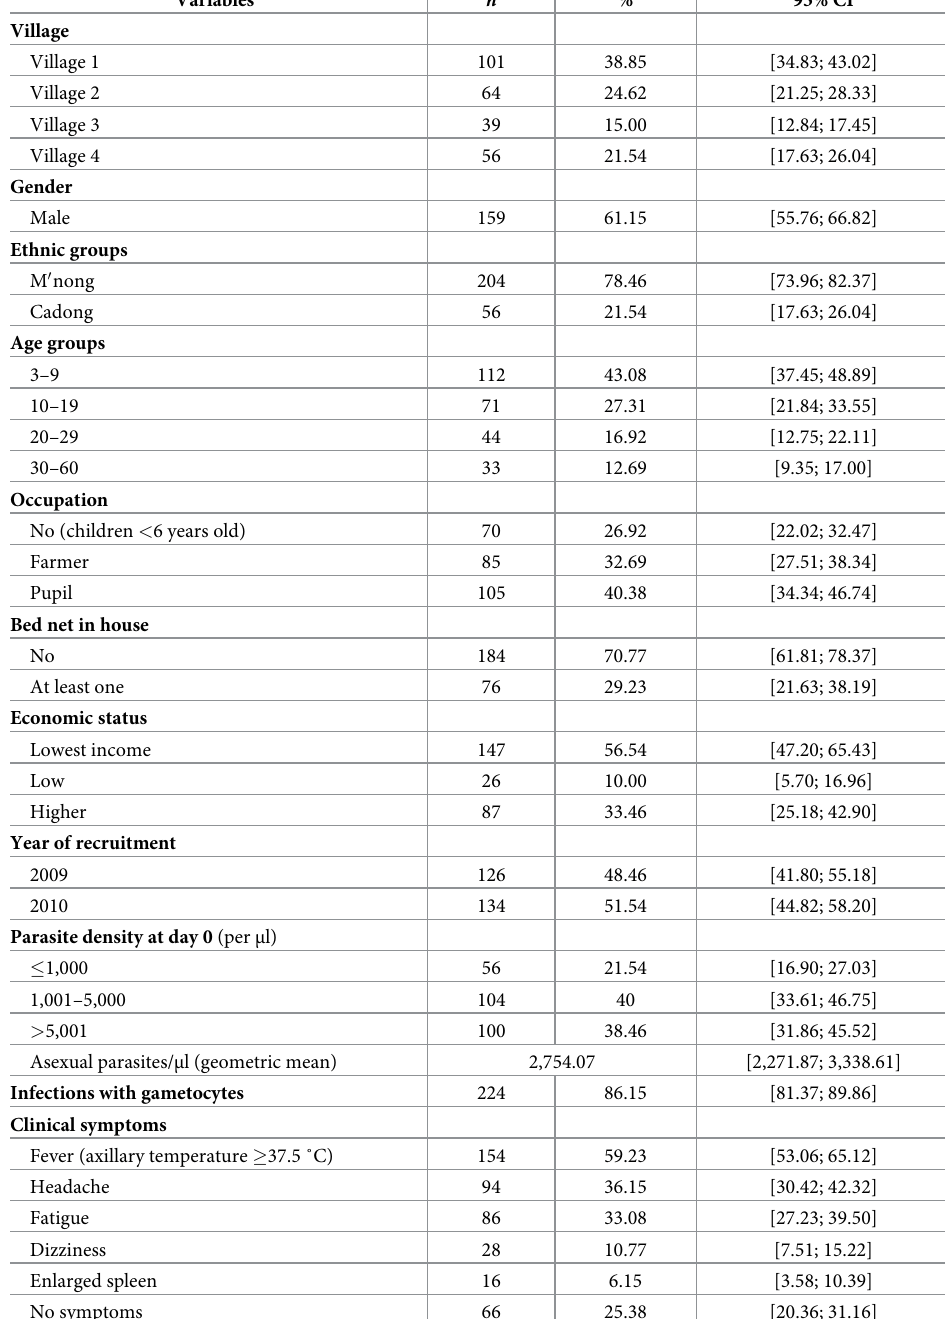
Table 1. Baseline characteristics of the 260 patients enrolled in the